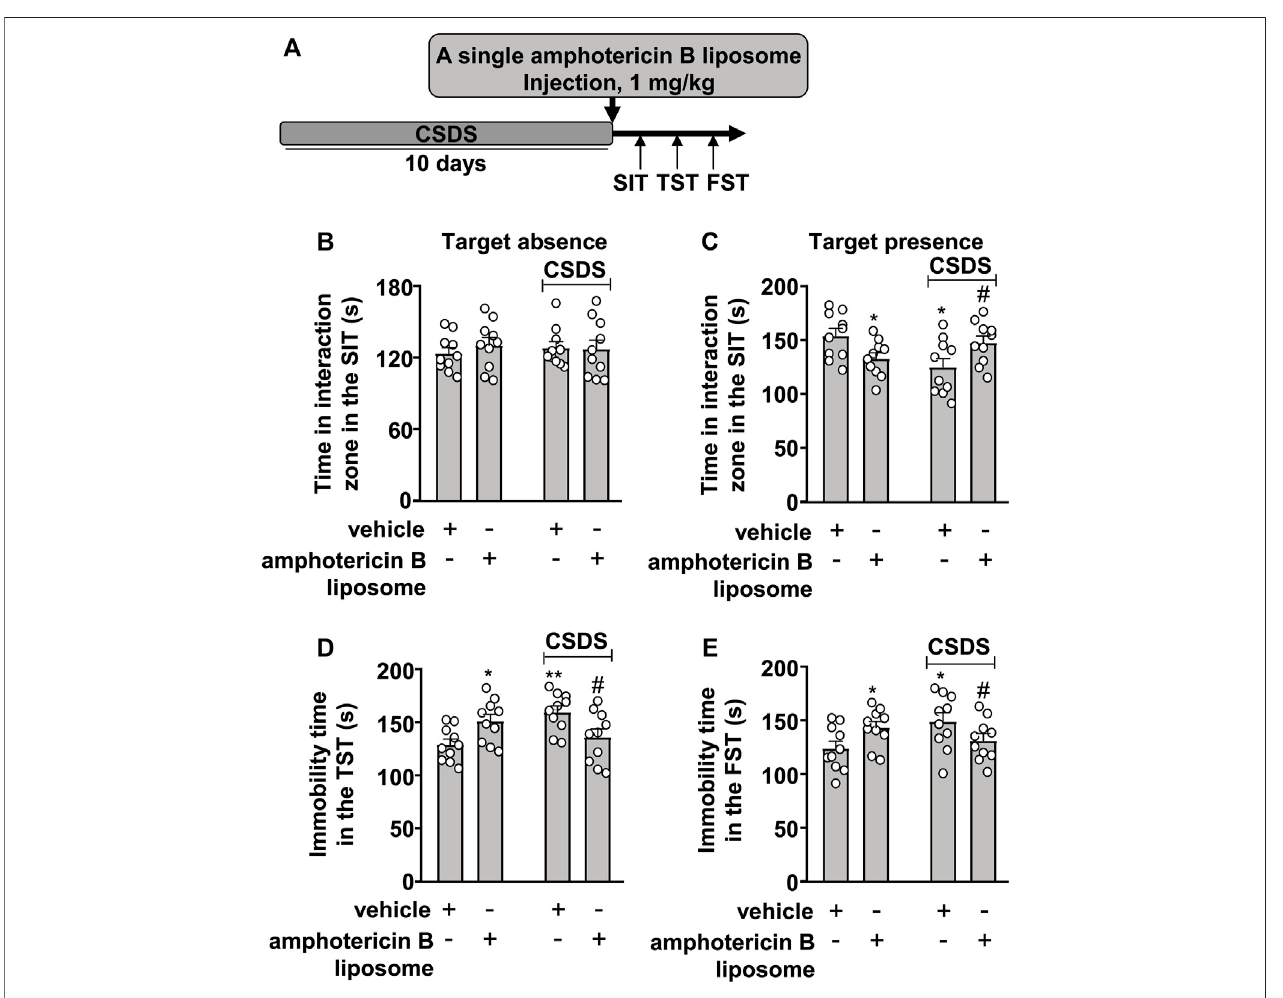
FIGURE 1 | Effect of post-stress amphotericin B liposome administration on CSDS-induced behavioral abnormalities in mice. (A) schematic diagram showing the time course of amphotericin B liposome injection after stress and behavioral testing in stress-naïve and CSDS mice. (B – E) Quantitative analysis showed that a single injection of amphotericin B liposome (1 mg/kg) after the discontinuation of stress reversed the decreased time spent in the interaction zone in the SIT (B,C) and the increasedimmobilitytime intheTST (D) andFST (E) inCSDSmice,andtreatment withamphotericinBliposome alonesigni fi cantlydecreasedthetime spentinthe interactionzoneintheSIT (B,C) andsigni fi cantlyincreasedtheimmobilitytimeintheTST (D) andFST (E) instress-naïvemice(n=10, p p < 0.05or pp p < 0.01vs.vehicle, # p < 0.05 vs. vehicle + CSDS). Data are shown as mean ± SEM.